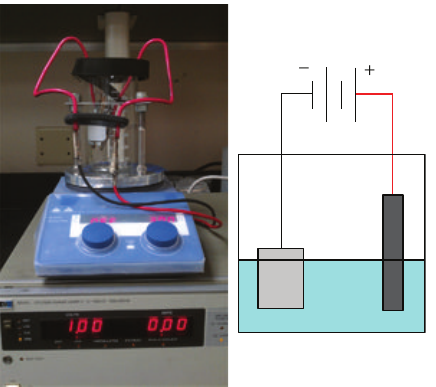
Figure 1: Electrochemical corrosion